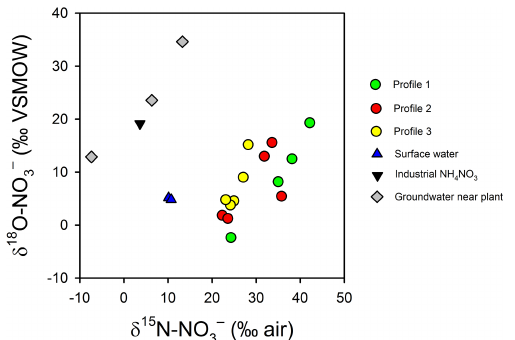
Figure 10. Variations in δ 15 N NO and δ 18 O NO in intertidal pore- 3 3 water, surface water, one synthetic NH 4 NO 3 sample from the plant and three groundwater samples collected underneath the plant (An- drew Minard, unpublished data). The enrichment in δ 15 N NO and 3 depletion in δ 18 O NO in porewater relative to the industrial source 3 suggest a complete turnover of the nitrate pool during groundwater